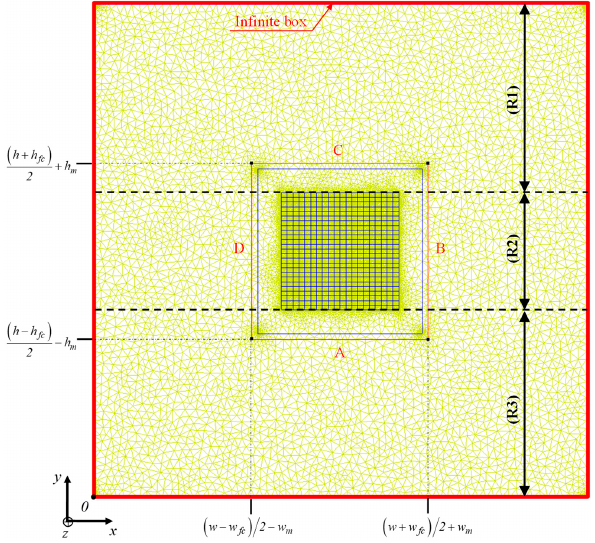
Figure 8. The 2D FEA mesh and paths of the magnetic field validation for comparison with { } { } = (see Table 1 for the various m m w ;h 5;5 mm